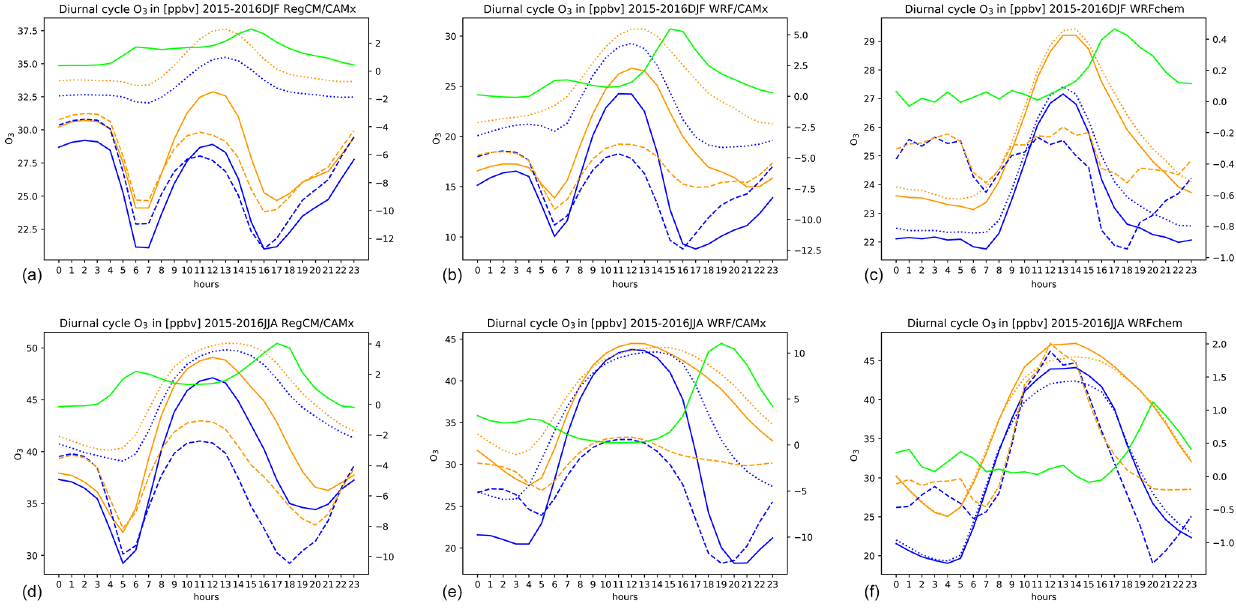
Figure 11. The average diurnal cycle of the absolute urban O 3 concentrations and their difference between different simulations for DJF (a– c) and JJA (d–f) and for the three models applied as columns: CAMx driven by RegCM, CAMx driven by WRF and WRF-Chem. Blue and orange lines denote the NOURBAN and URBAN cases, respectively. Solid lines stand for the reference values with 100% urban emissions, while dotted lines are for the 0% urban emission runs (both belonging to the left vertical axis). Dashed lines mean the UEI evaluated for both the NOURBAN and URBAN cases, and the green line denotes the (cid:49) UEI (right vertical axis). Units in parts per billion volume